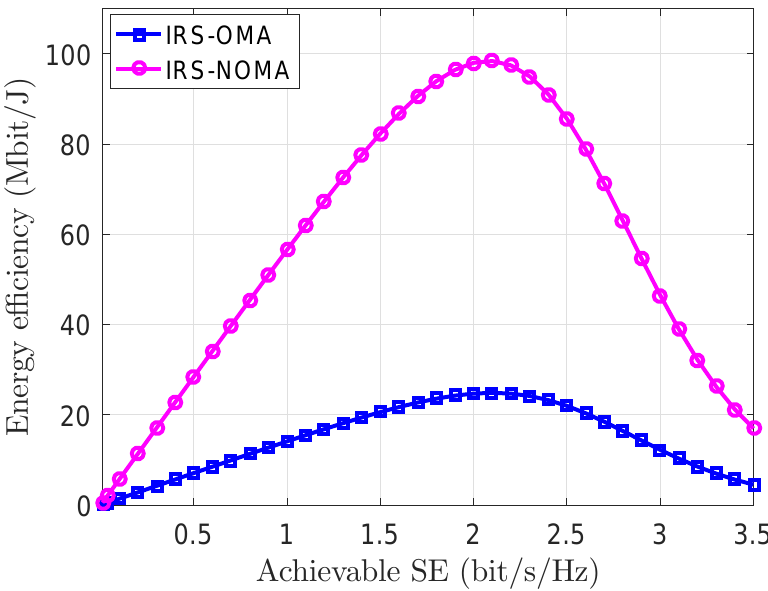
Figure 6. EE-SE trade-off of both IRS-NOMA against